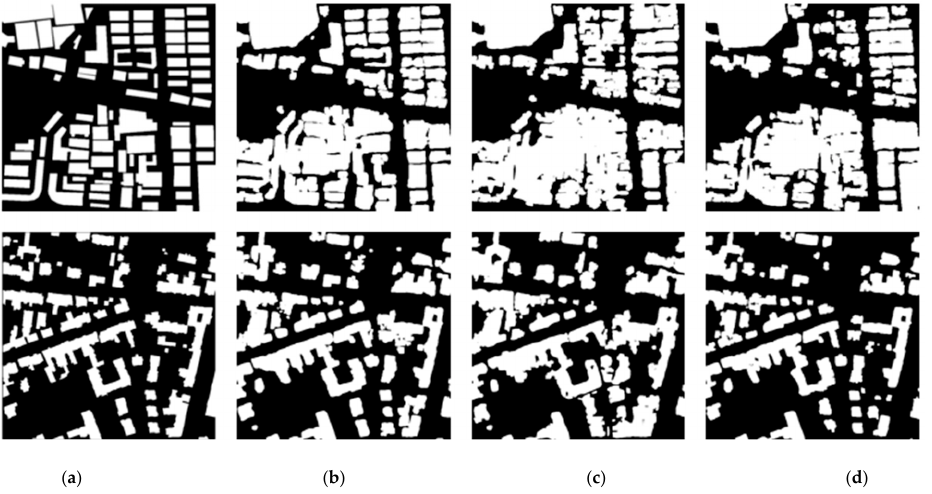
Figure 3. Semantic segmentation results of our framework with three different models in two dif- ferent target domains. The first and second rows correspond to the results of the first image and the second image, respectively. The white area indicates the building footprint. ( a ) Ground truth. ( b ) Results of our framework based on UNet. ( c ) Results of our framework based on PSPNet. ( d ) Results of our framework based on LinkNet.